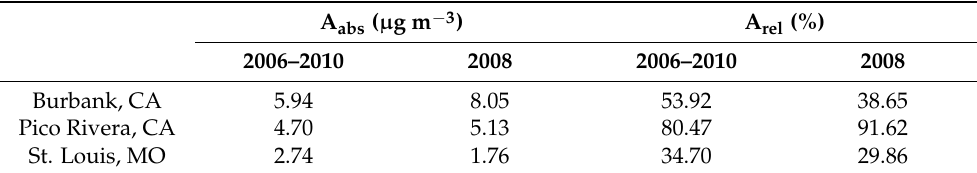
Table 2. 2006–2010 and 2008 (NEI reported year) mean June, August, September (JAS) diurnal HCHO amplitudes at the three AQS sites in Figure 2. A abs is the absolute amplitude, and A rel is the relative amplitude.